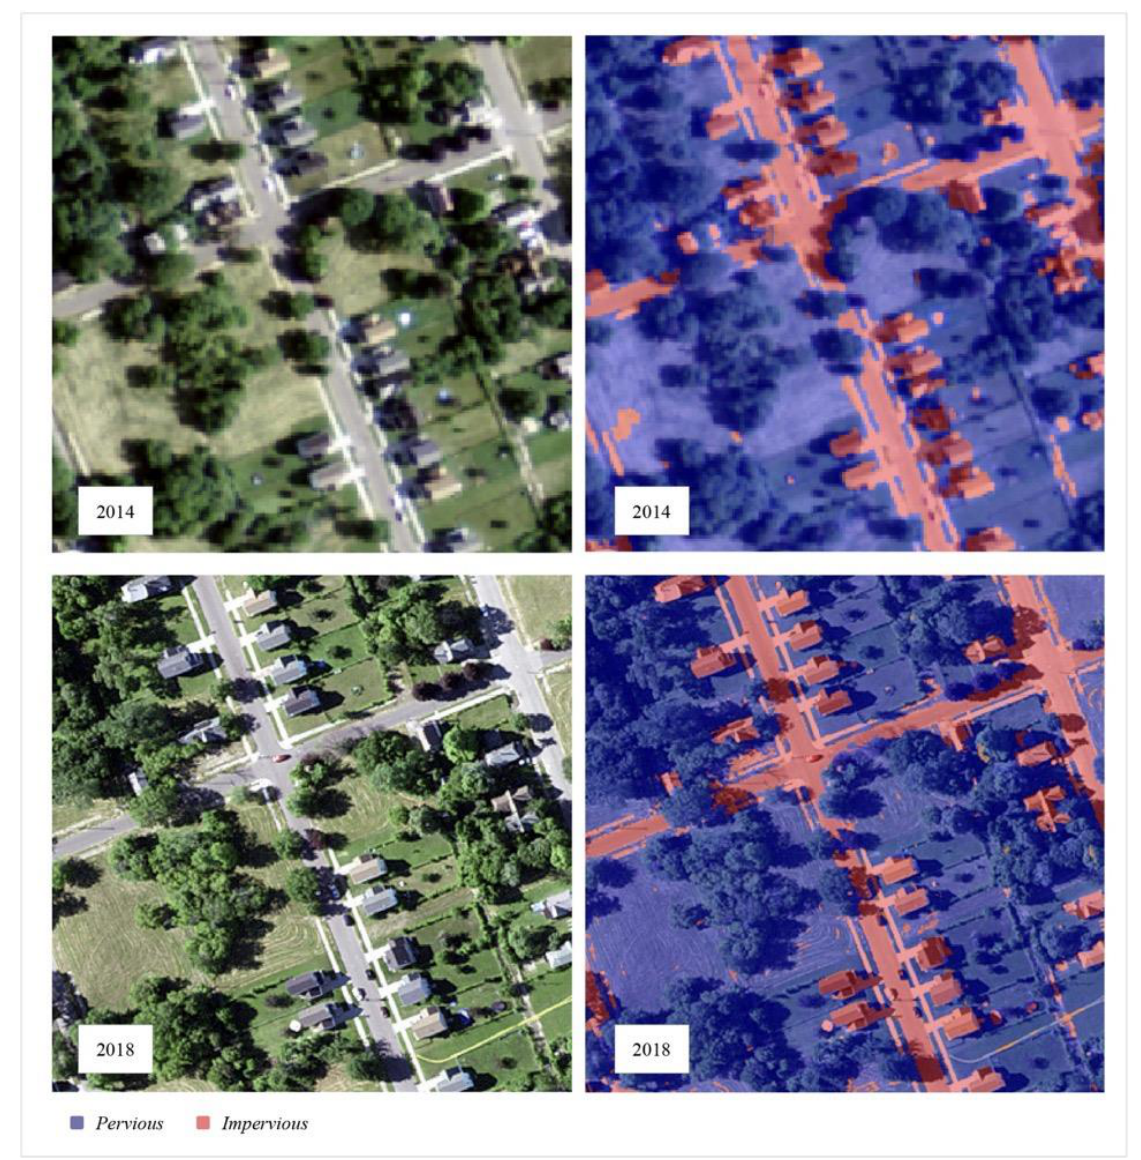
Figure 10. Batch GEOBIA, median demolition rate, Core City, Detroit. Within the select square meter thresholds, NAIP 2018 consistently detected fewer vacant residential parcel lots than NAIP 2014. Conversely, the commission error in NAIP 2014 was consistently larger than in NAIP 2018. With the same land area, more residential lots were selected, increasing both the rate selection as well as the inclusion of falsely identified empty lots. This may be due to the different original imagery spatial resolutions and different conditions and view angles of vegetation surrounding